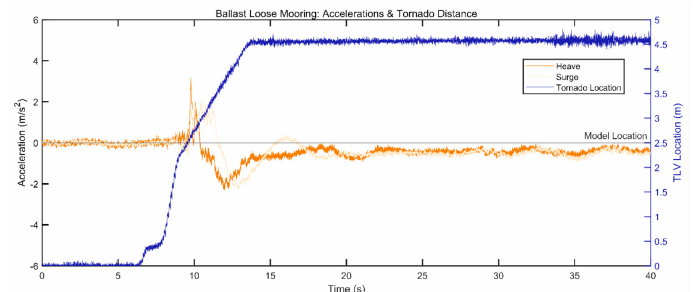
Figure 14. Heave and Surge accelerations and bell mouth distance (Tornado location) for configura- tion